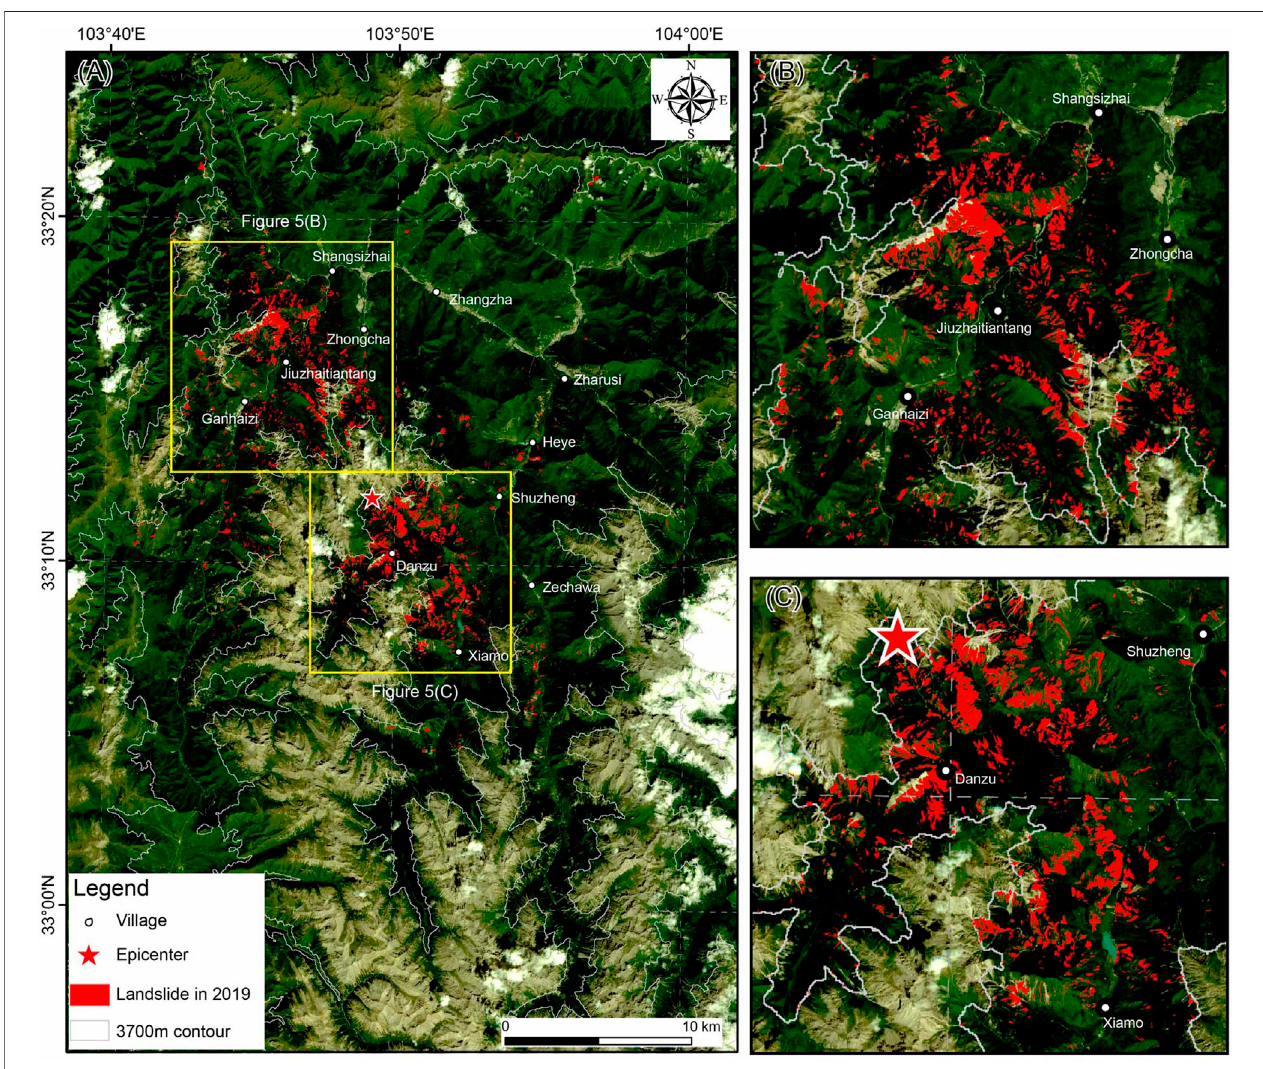
FIGURE 5 | Inventory map of the landslide in 2019 (A) Landslide map (B) Landslide map of Jiuzhaitiantang (C) Landslide map of Panda Lake.